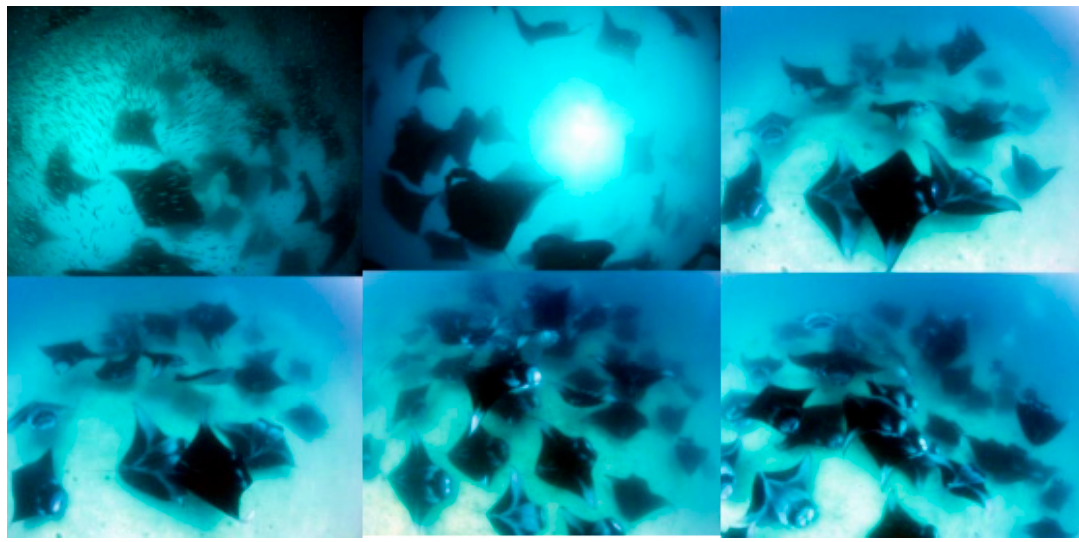
Figure 3. Cyclone foraging strategy.